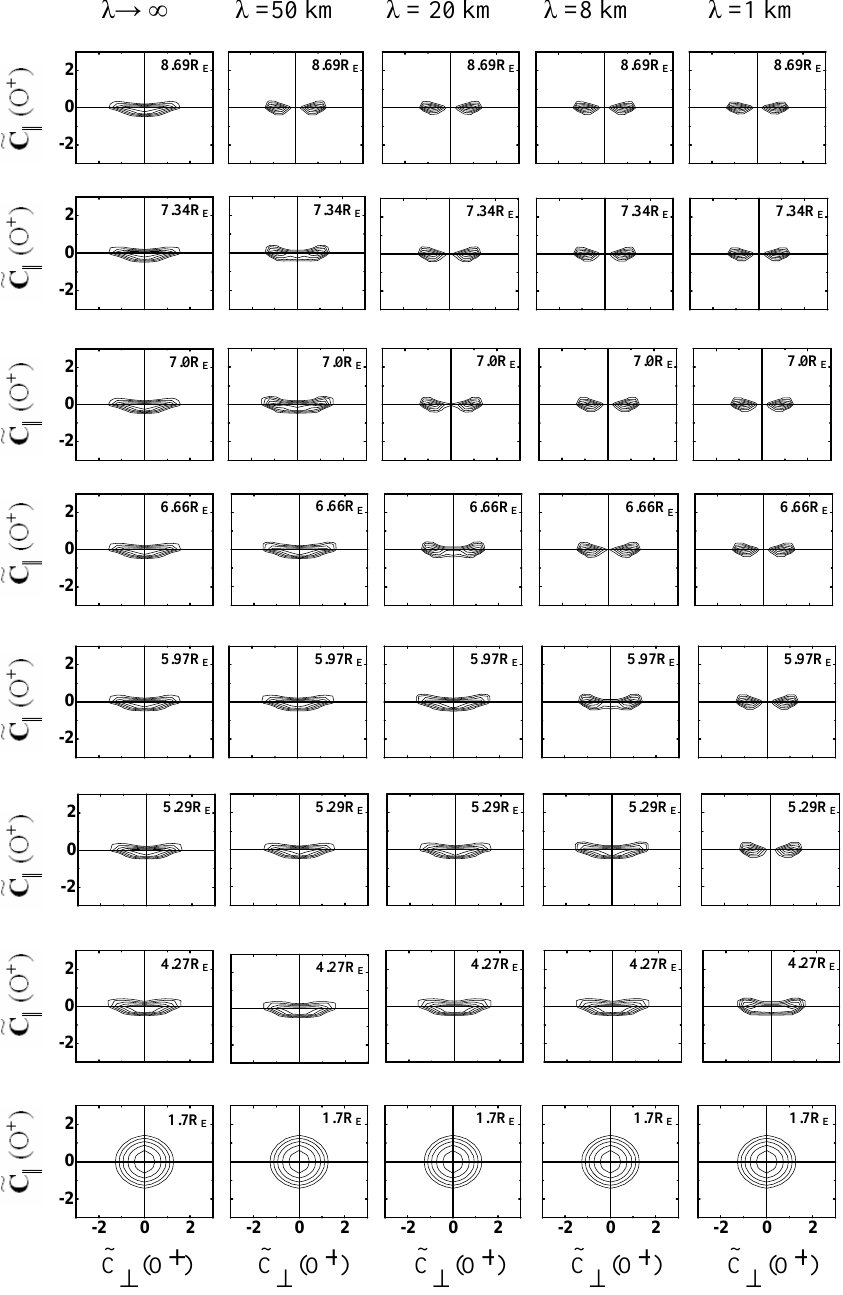
Fig. 2. O + ions velocity distribution functions at different geocentric distances (1.7, 4.27, 5.29, 5.97, 6.66, 7.0, 7.34 and 8.69 R E ) for different electromagnetic turbulence wavelengths ( λ ⊥ ) , the wavelengths considered here are λ ⊥ → ∞ (1st panel), λ ⊥ = 50km (2nd panel), λ ⊥ = 20km (3rd panel), λ ⊥ = 8km (4th panel), and λ ⊥ = 1km (5th panel). f ( O + ) is represented by equal values contours in the normalized velocity ( ˜ c || , ˜ c ⊥ ) plane, where ˜ c = (cid:2) v − u( O + ) (cid:3)(cid:14)(cid:2) 2 kT ( O + ) (cid:14) m( O + ) (cid:3) 1 / 2 . The contour levels decrease successively by a factor e 1 / 2 rom the